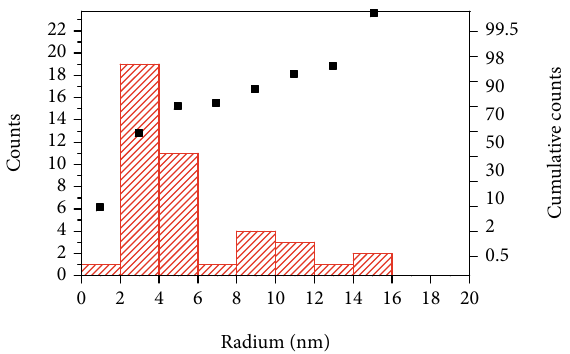
Figure 13: Distribution graph of immobile water fi lm thickness in cores of tight sandstone in Dibei area.